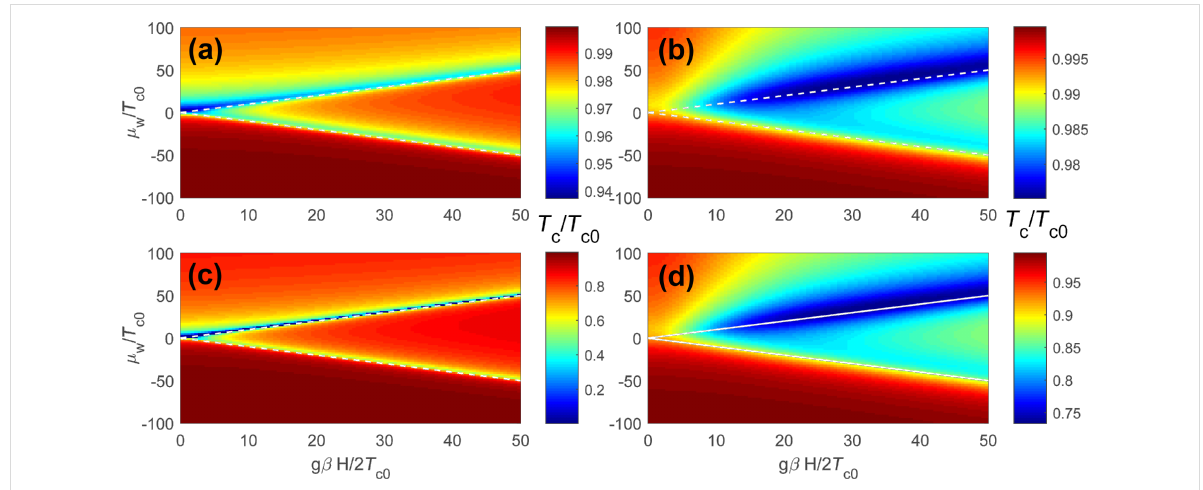
Figure 2: Color plot of the critical temperature of the system as a function of the chemical potential μ w and the Zeeman energy h = g β H /2 for ε so = m w α 2 = 0.46 T c0 and several values of and with . In panels (a) and (b) Γ w = 0.1 T c0 , while in panels (c) and (d) we take Γ w = T c0 . In panels (a) and (c) Γ s = 0.1 T c0 , in panels (b) and (d) Γ s = 10 T c0 . In all panels the white dashed lines denote the boundaries between nontopological and topological regimes μ w = ± h .